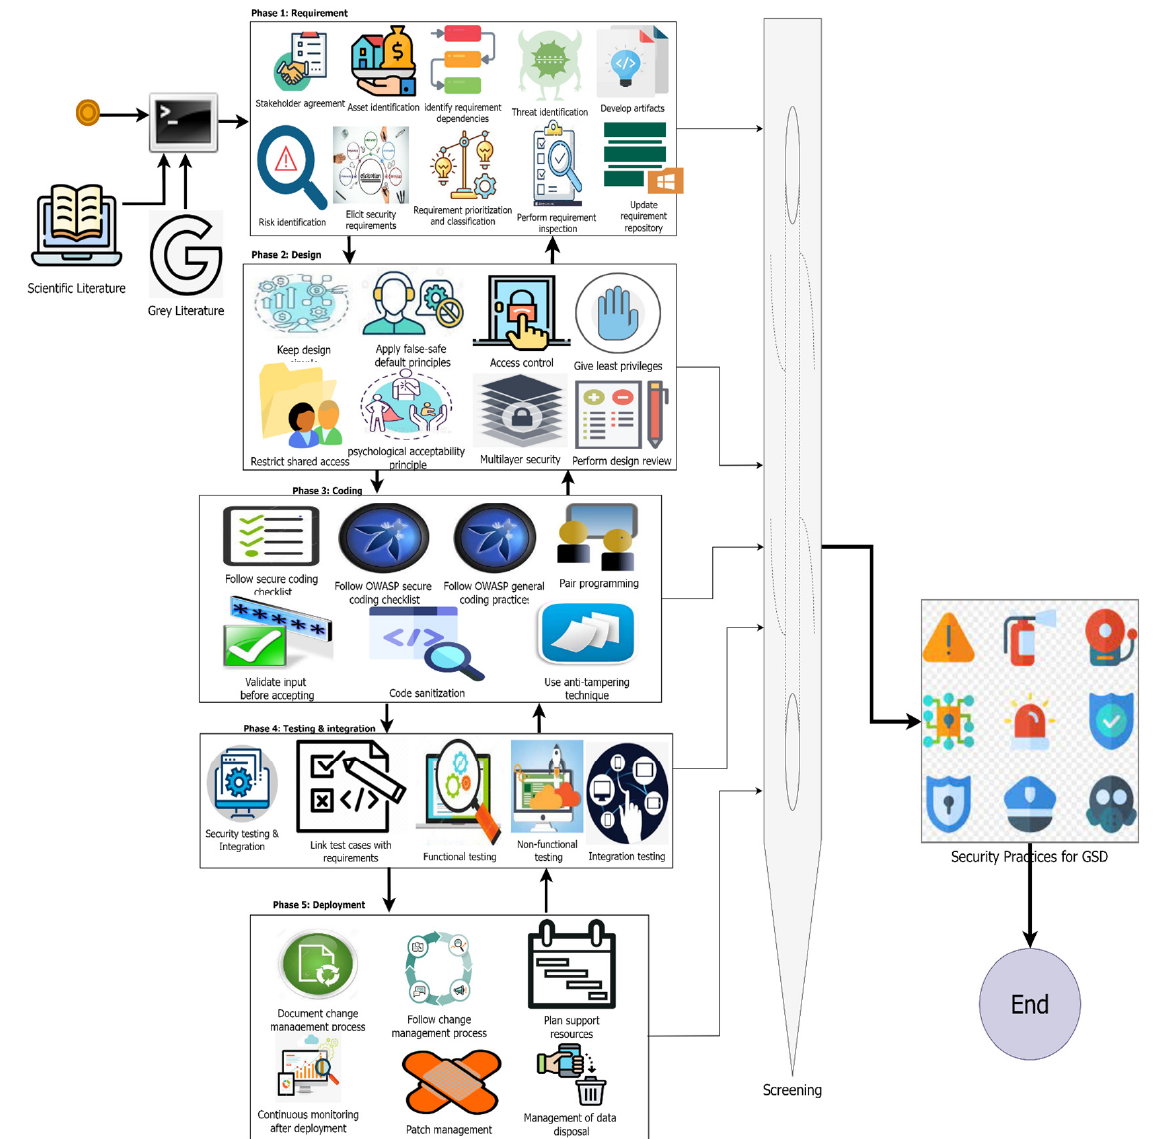
Figure 6. Proposed framework for identification of security practices for GSDLC.